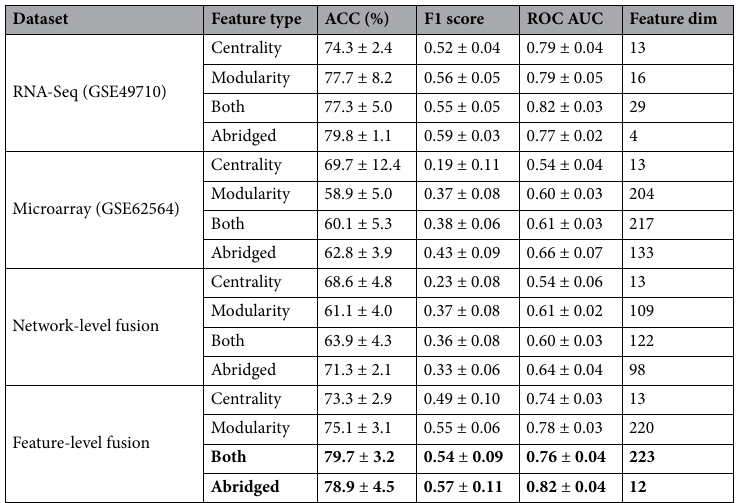
Table 1. Results of DNN on SEQC dataset. Significant values are in bold.